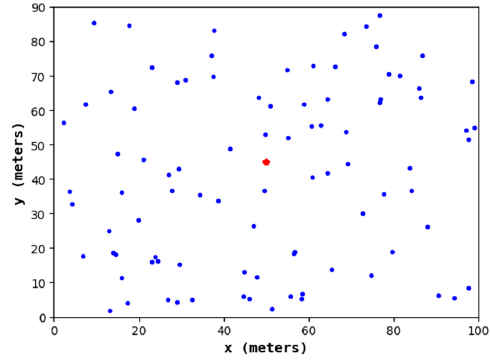
Figure 11. The node distribution diagram of the random node deployment strategy.